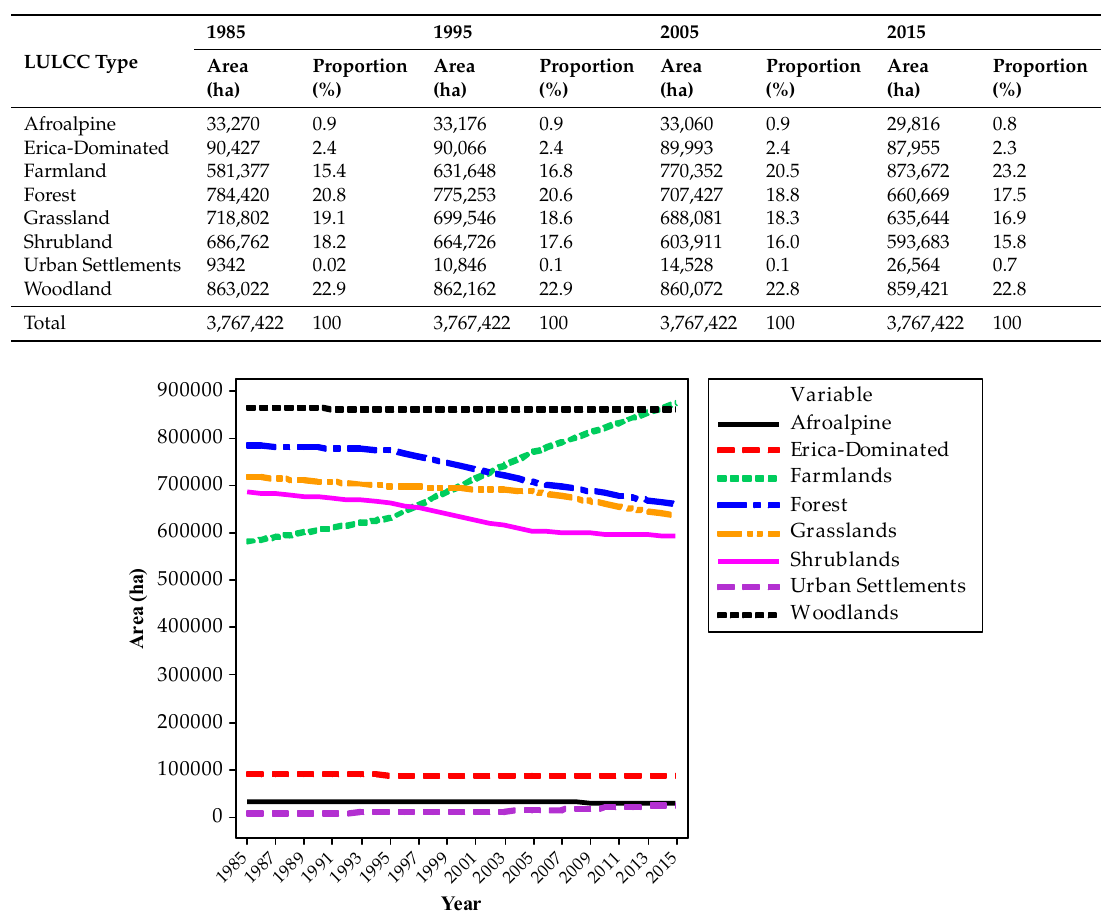
Figure 3. LULC changes in BMER during 1985–2015.